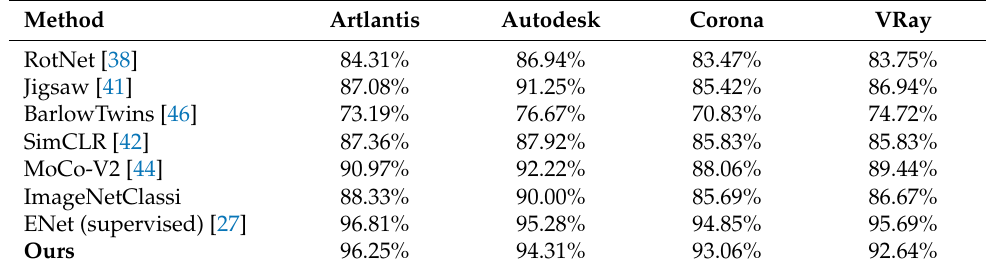
Table 4. Test accuracy of different methods under the fine-tuning evaluation protocol where the fine-tuning was conducted on 20% of the training set of CG forensics datasets. The presented results are classification accuracies on the testing set of the Artlantis, Autodesk, Corona and VRay datasets.